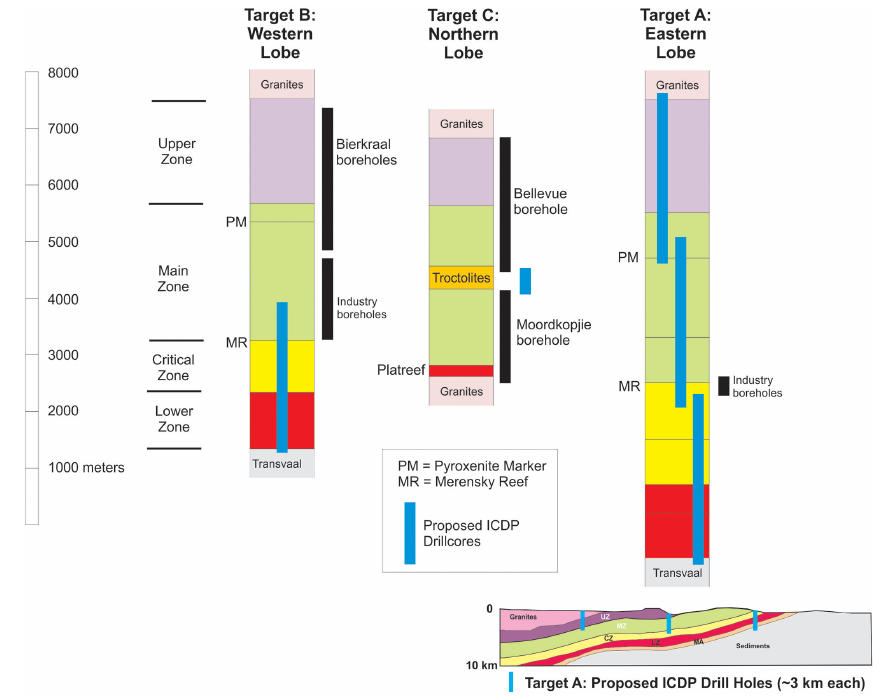
Figure 3. Schematic stratigraphic sections of the Bushveld lobes illustrate ICDP targets A, B and C. The cross section of the eastern lobe (right) explains the staggered-hole concept for target A (see